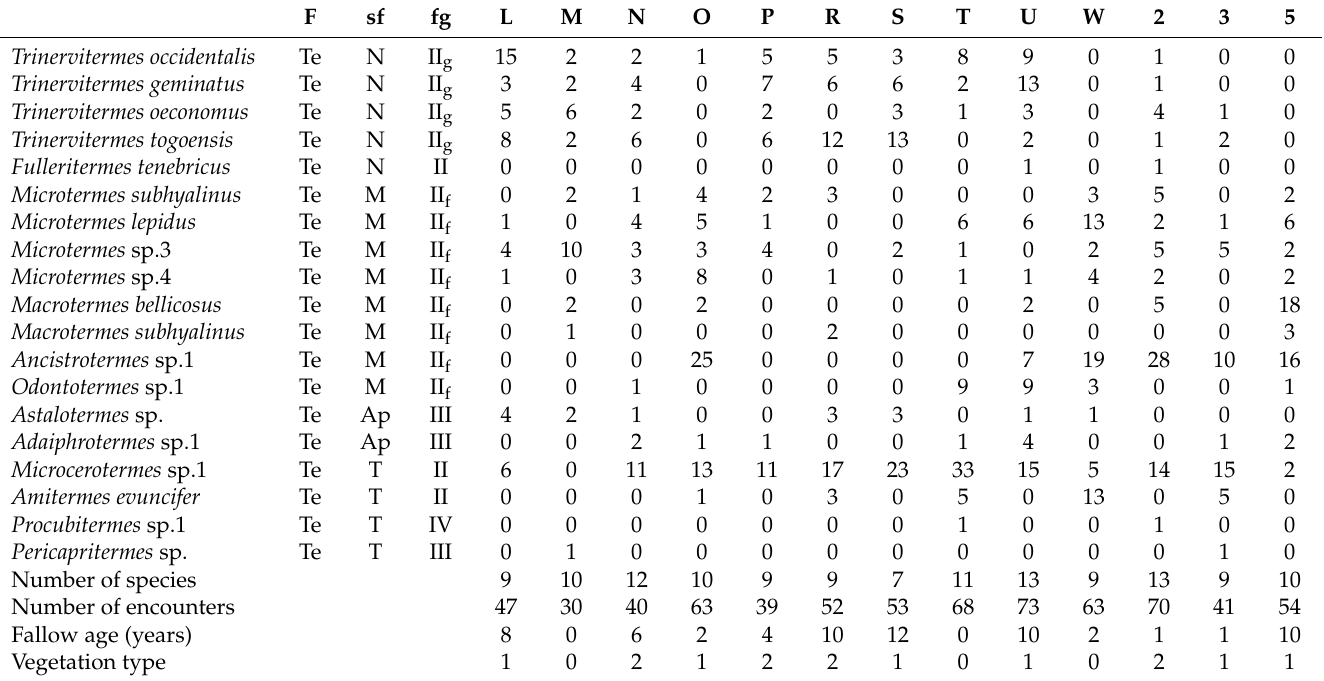
Table 1. Abundances and encounters of the 19 species of the regional species pool in all study plots including data on fallow age and vegetation